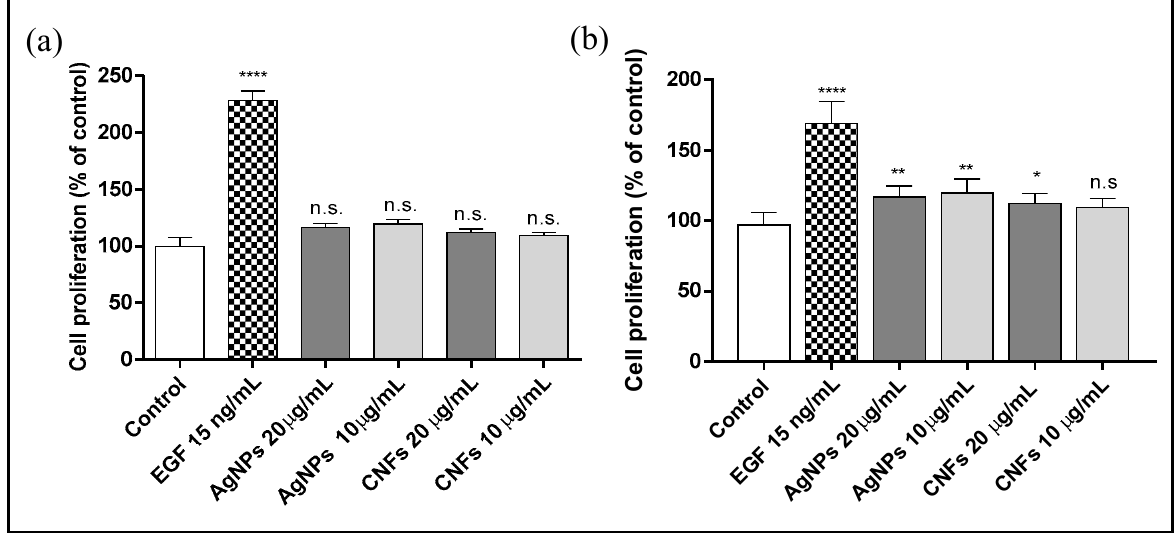
Figure 7. Proliferative activity of AgNPs or CNFs in human keratinocyte (HaCaT) cells stimulated by their exposure to non-cytotoxic concentrations (10 and 20 µg/mL) for 72 ( a ) or 96 ( b ) hours. Data are shown as the mean ± standard deviation of six replicates. The ANOVA results of the AgNP and CNF concentrations and epidermal growth factor (EGF) with respect to control are given in the plot. * p < 0.05; ** p < 0.01; **** p < 0.0001; n.s: not significant.